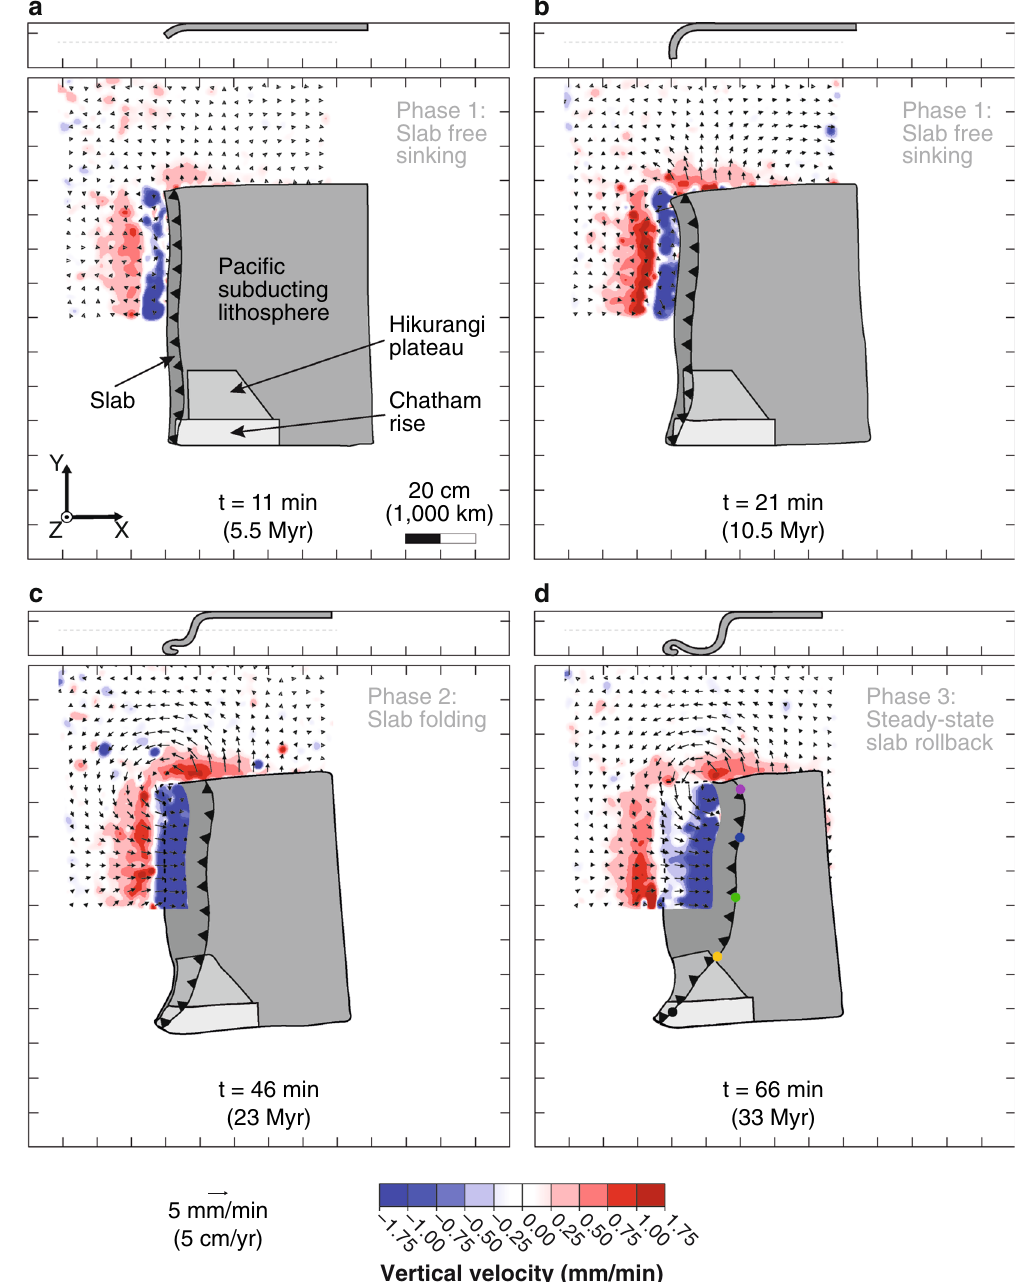
Figure 3. Predicted SIMU position and magnitude from laboratory subduction model. The four panels (a–d) show the position of the plate, slab, and trench (line drawing) at different stages of the subduction process with: ( a , b ) the first phase of free slab sinking; ( c ) the end of the second phase of slab folding at the rigid bottom boundary that simulates the 660 km mantle discontinuity; ( d ) the third phase of steady-state slab rollback. On each panel we show the three components of the computed mantle flow velocity field at 5.5 cm (275 km) depth in map view (bottom), and cross-sectional slab geometry at the northern edge (representing the northern Tonga subduction zone edge)